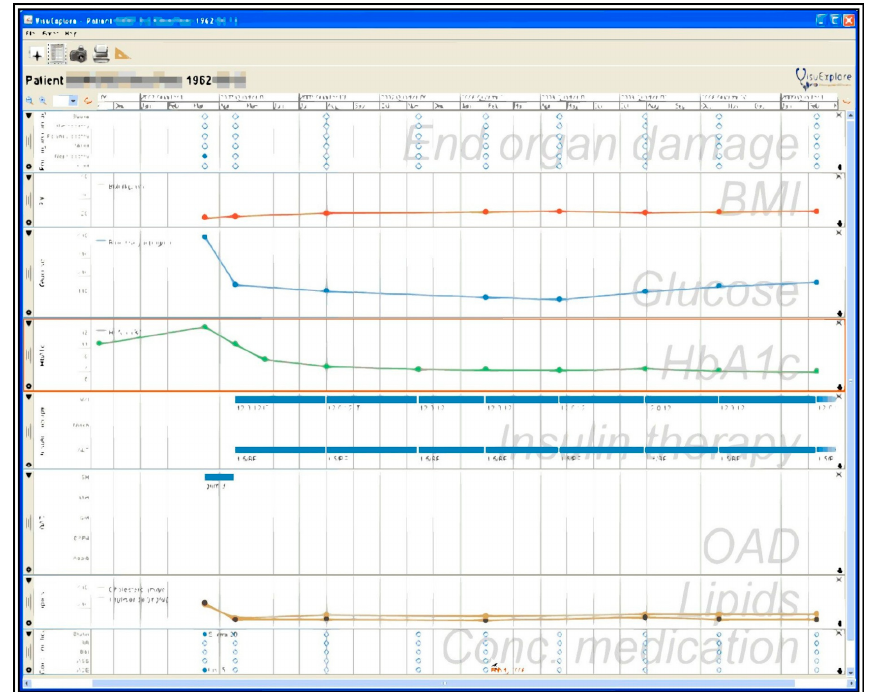
S, Rind A, et al., copyright